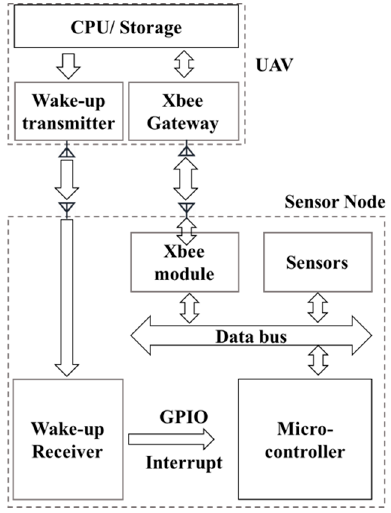
Figure 5. Design for the radio frequency (RF)-based active wake-up mechanism.